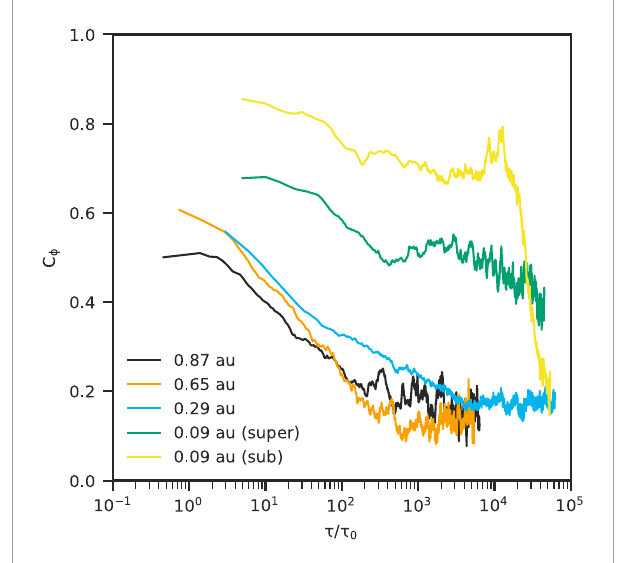
FIGURE 4 Coherence index, C ϕ , calculated for fluctuations parallel to the mean magnetic field at each distance using Helios 2 and PSP observations. Here, τ 0 is the local proton gyro period calculated at each distance.